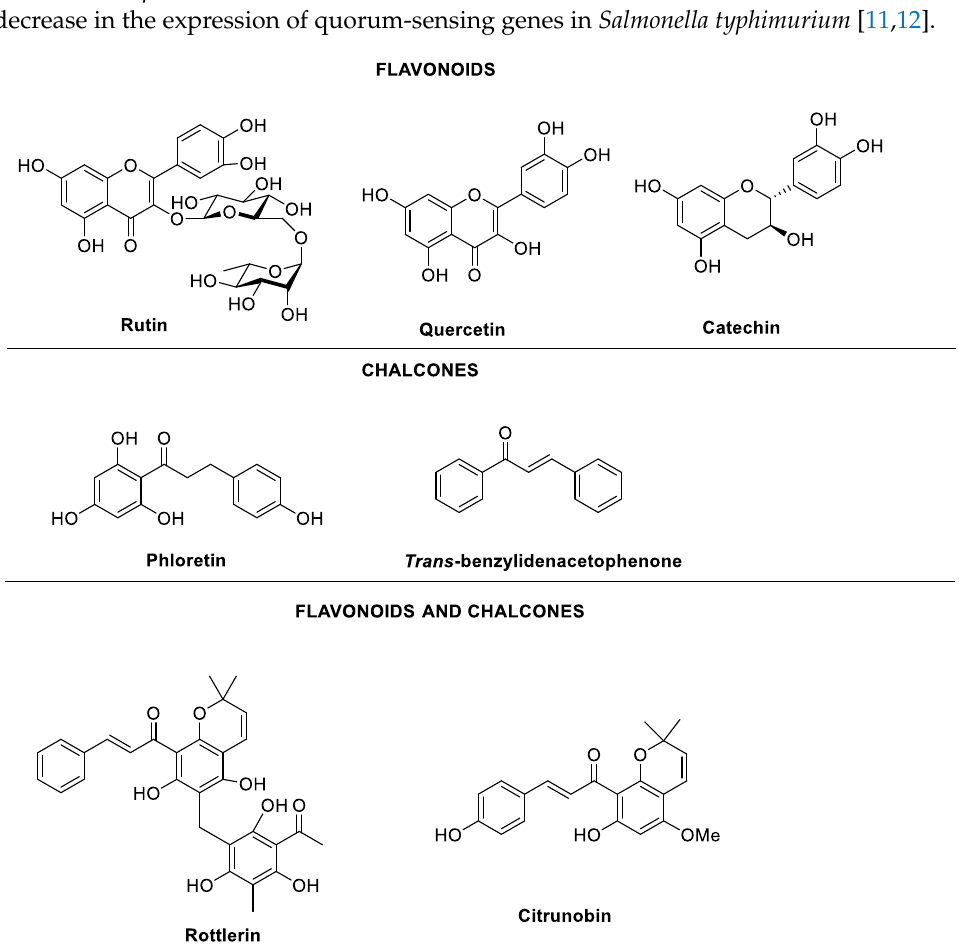
Figure 1. Flavonoid- and chalcone-containing natural products as anti-virulence and quorum sensing inhibitors.